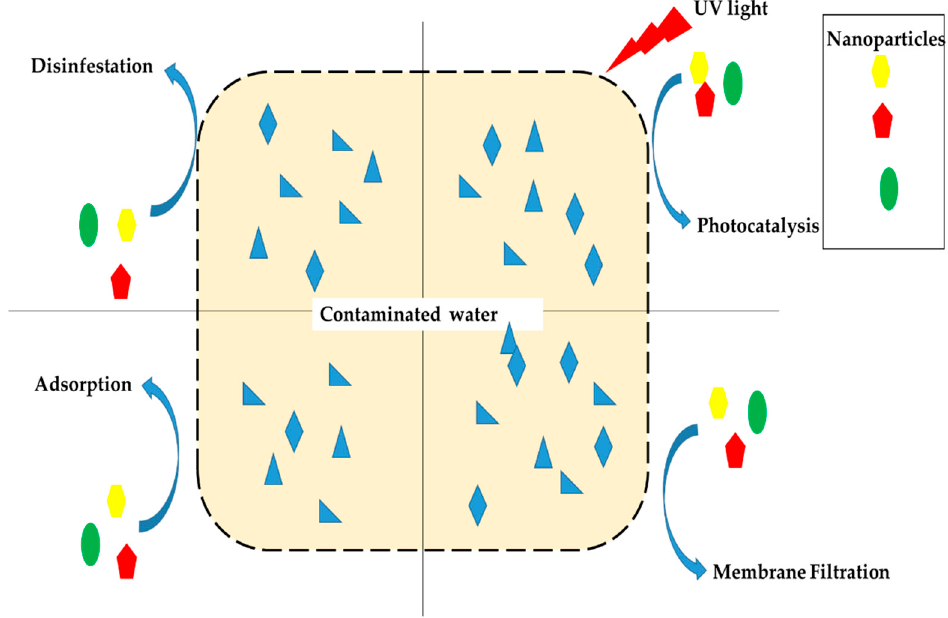
Figure 1. Different applications of nanoparticles in wastewater treatment, modified from [18] .